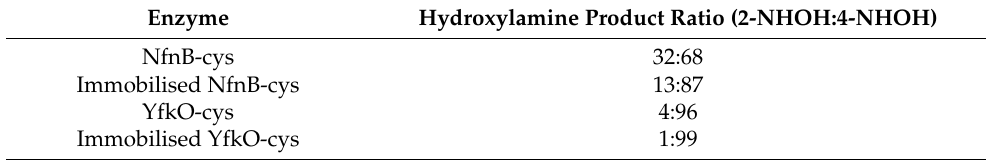
Table 2. The ratio of hydroxylamine derivatives formed upon reacting free and immobilised YfkO-cys, compared to those we have previously published for NfnB-cys